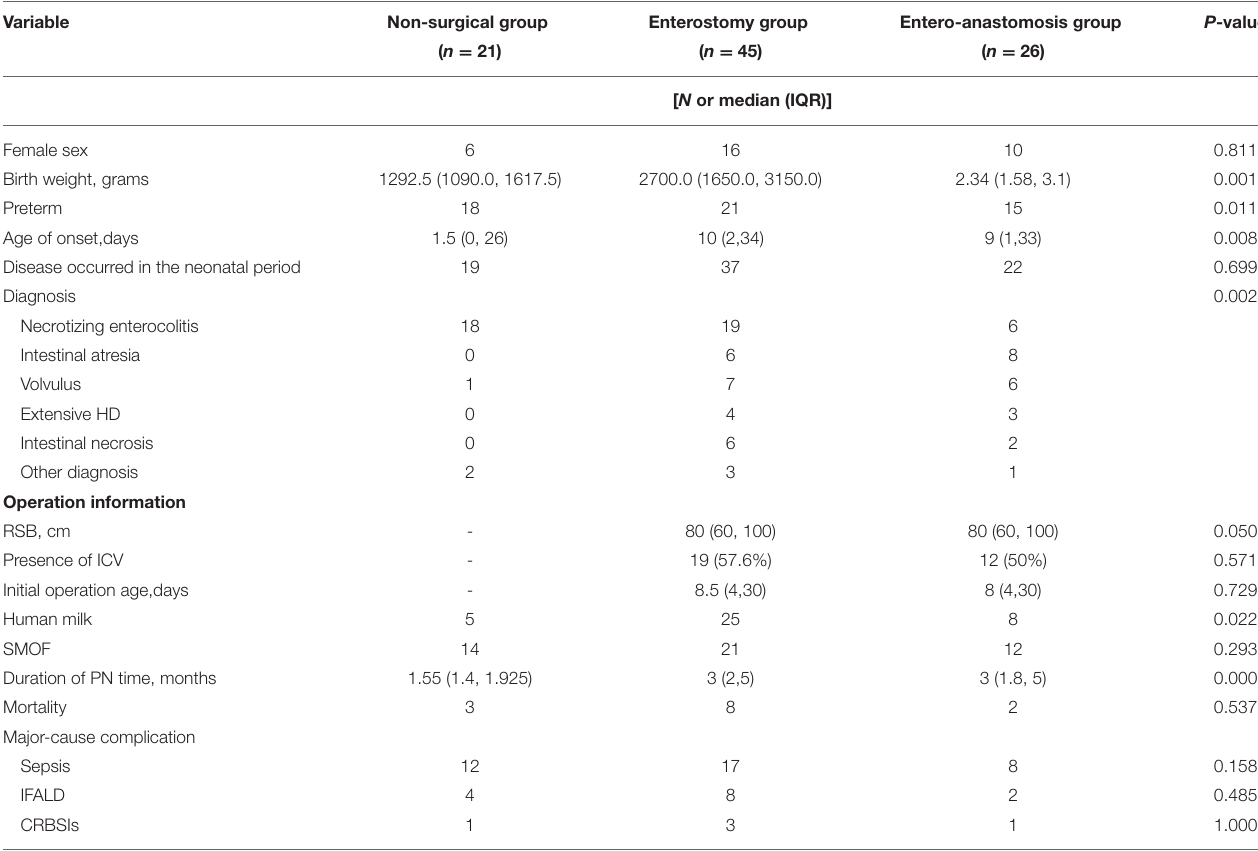
TABLE 2 | Clinical statistics of the study population in different subgroups of treatment with pediatric intestinal